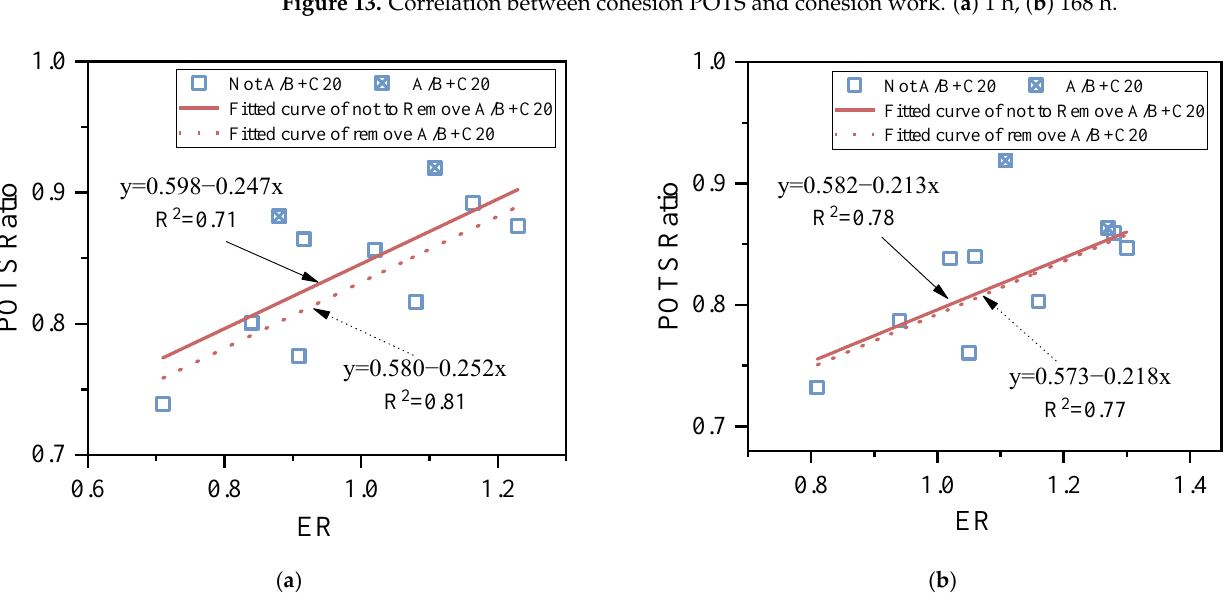
Figure 14. Correlation between POTS ratio and ER. ( a ) 1 h, ( b ) 168 h.